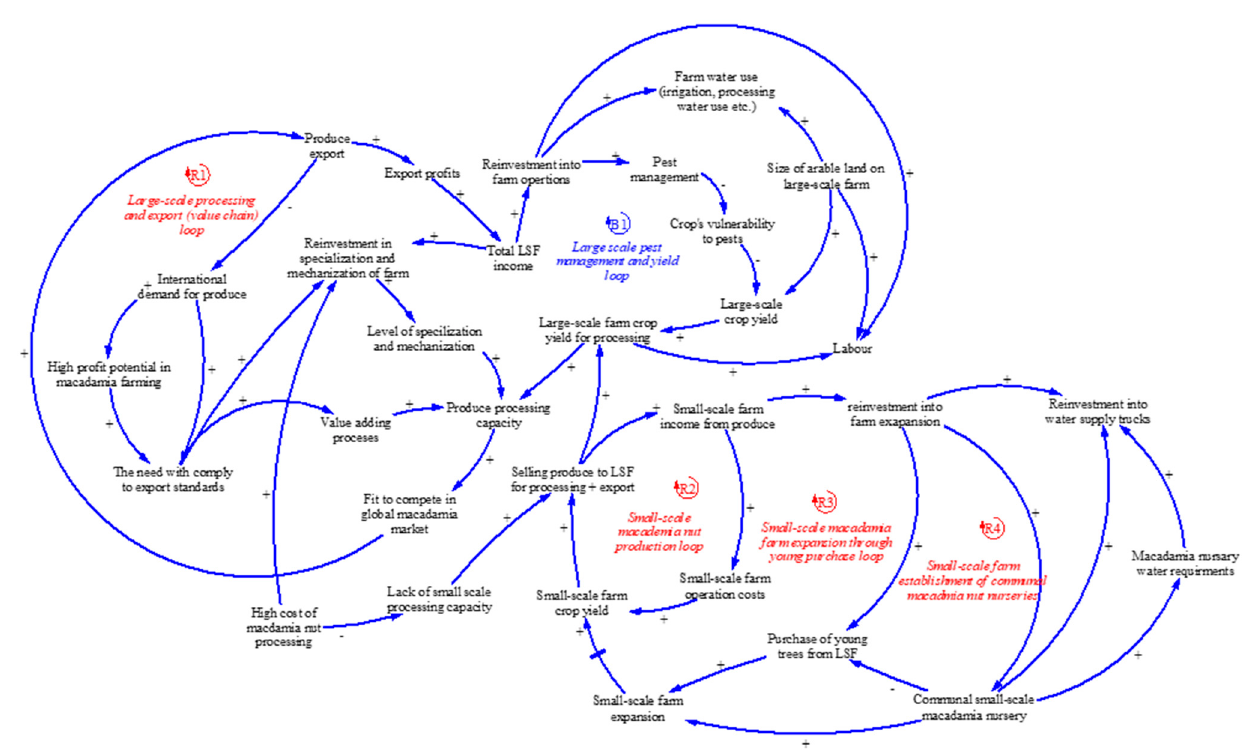
Figure 3. Causal loop diagram (CLD) showing macadamia nut farming systems in the Vhembe district, Limpopo. Arrows connect two or more variables of interest and are causal links that run in the stated direction. ‘+’ = a positive relationship, indicating that the causality runs in the same direction (i.e., an increase in variable A will cause an increase in variable B and vice versa); ‘ − ’ = a negative relationship, indicating that the causality runs in the opposite direction (i.e., an increase in variable A will cause a decrease in variable B and vice versa). The balancing feedback loops are numbered Bn and labelled in blue font. The reinforcing feedback loops are numbered Rn and labelled in red font. LSF refers to Large-scale farm/farming. Adapted with permission from Selebalo et al., [41]. 2022. Itumeleng Selebalo.